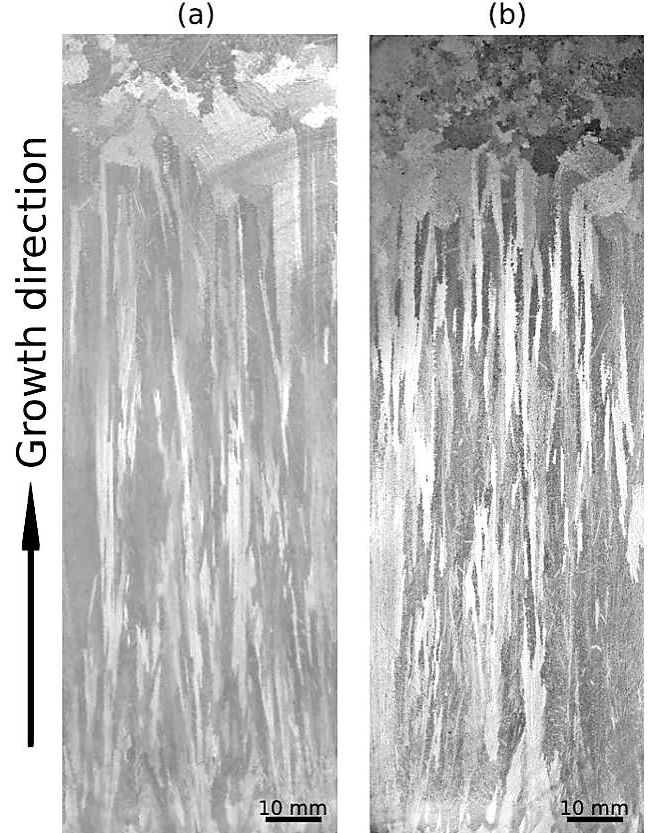
Figure 2. Directionally solidified (DS) macrostructures characterizing: ( a ) Al-11wt. %Si-3wt. %Cu and ( b ) Al-11wt. %Si-4.5wt. %Cu alloy castings.